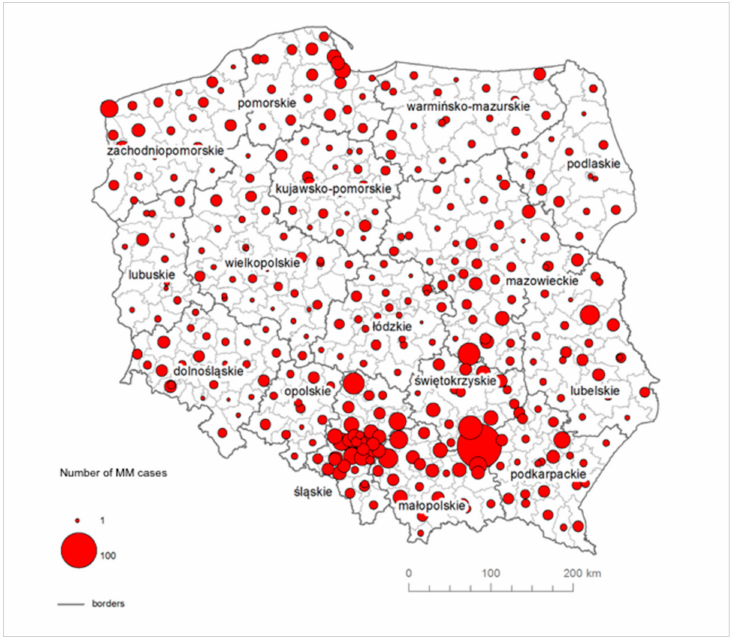
Figure 4. The absolute number of MM cases in counties due to the environmental exposure to